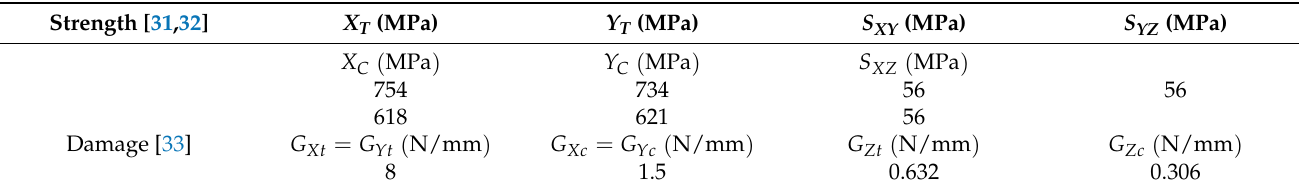
Table 3. Strength and damage data for SiC f /SiC